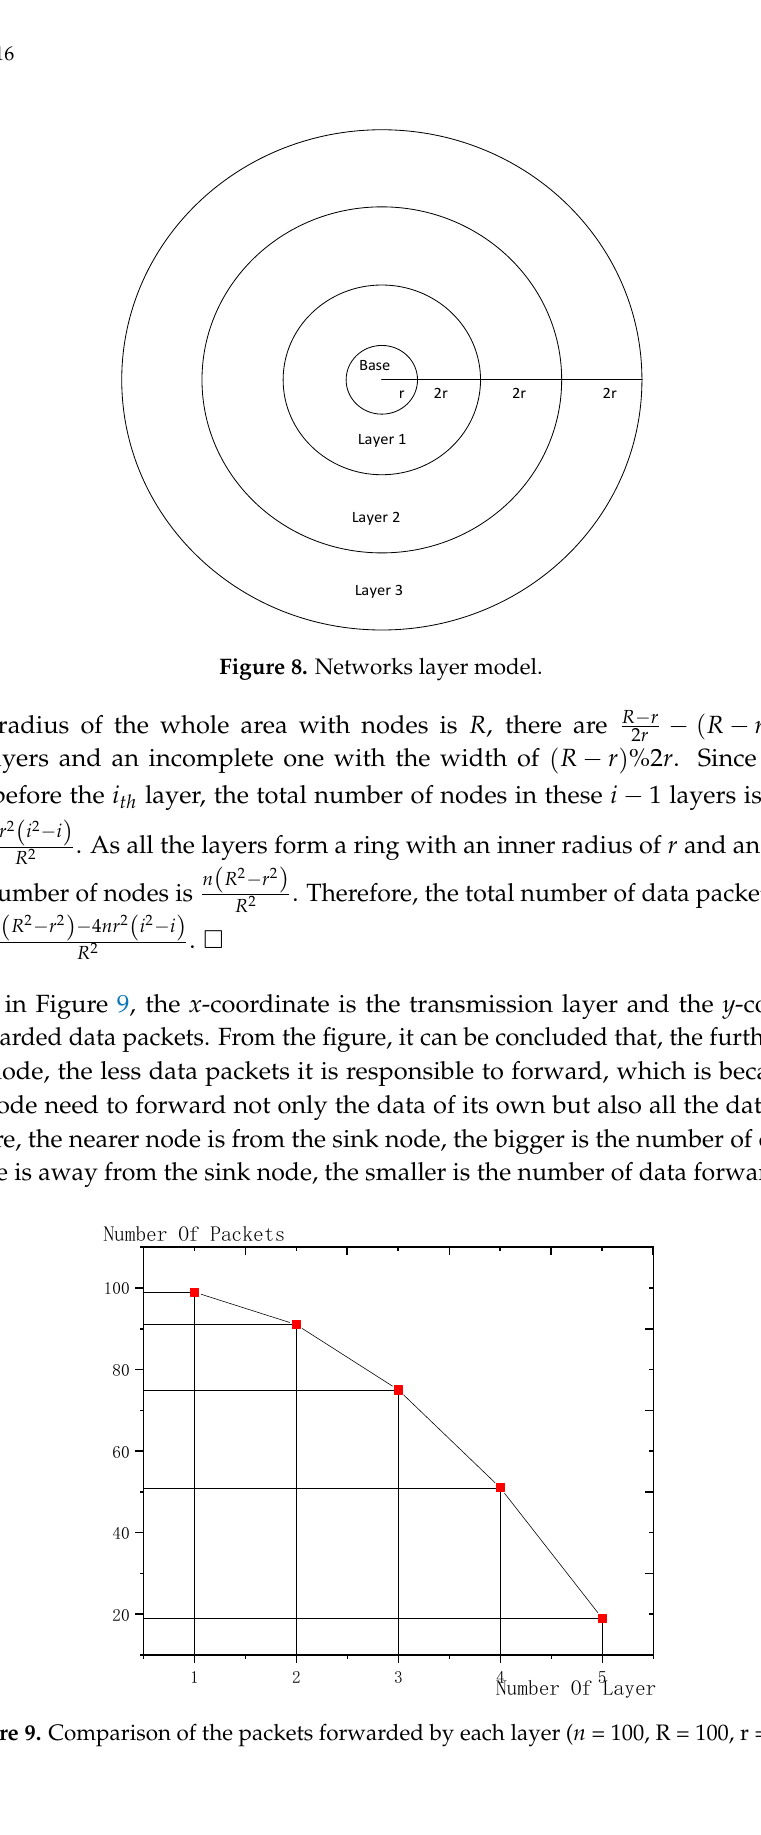
Figure 9. Comparison of the packets forwarded by each layer ( n = 100, R = 100, r = 10).